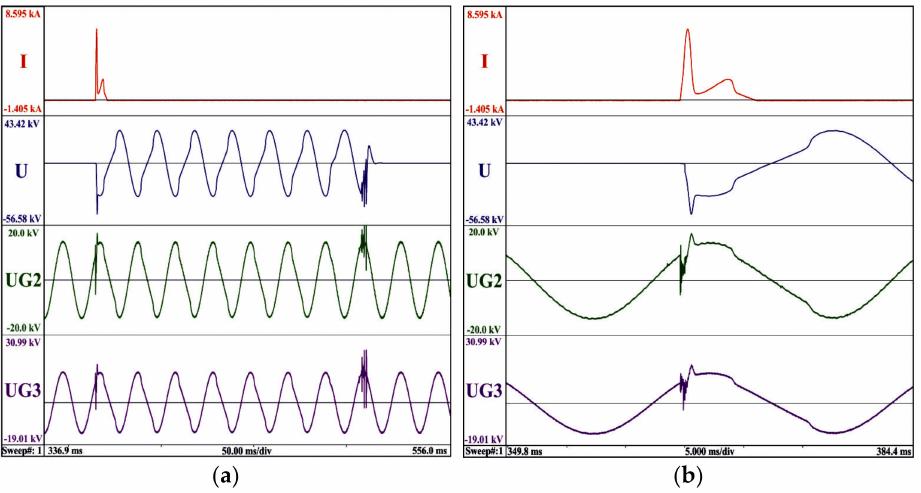
Figure 8. ( a ) Oscillogram obtained for the making angle of short-circuit current of 43.7 electrical degrees; ( b ) connection detail in the